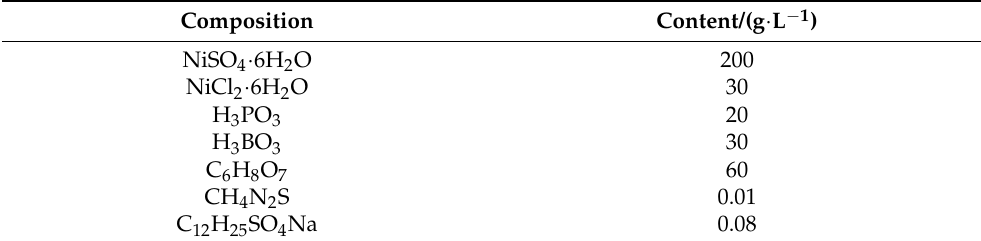
Table 1. Composition of the plating solution.